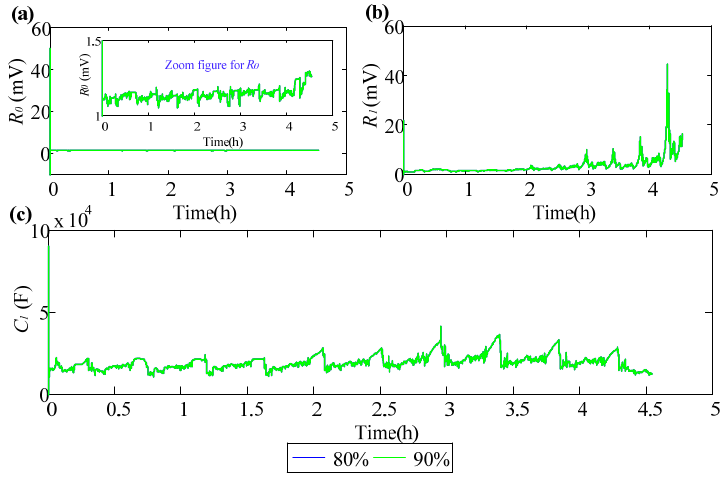
Figure 15. Model parameter identification results of the LiMn 2 O 4 cell: ( a ) R 0 ; ( b ) R 1 ; ( c ) C 1